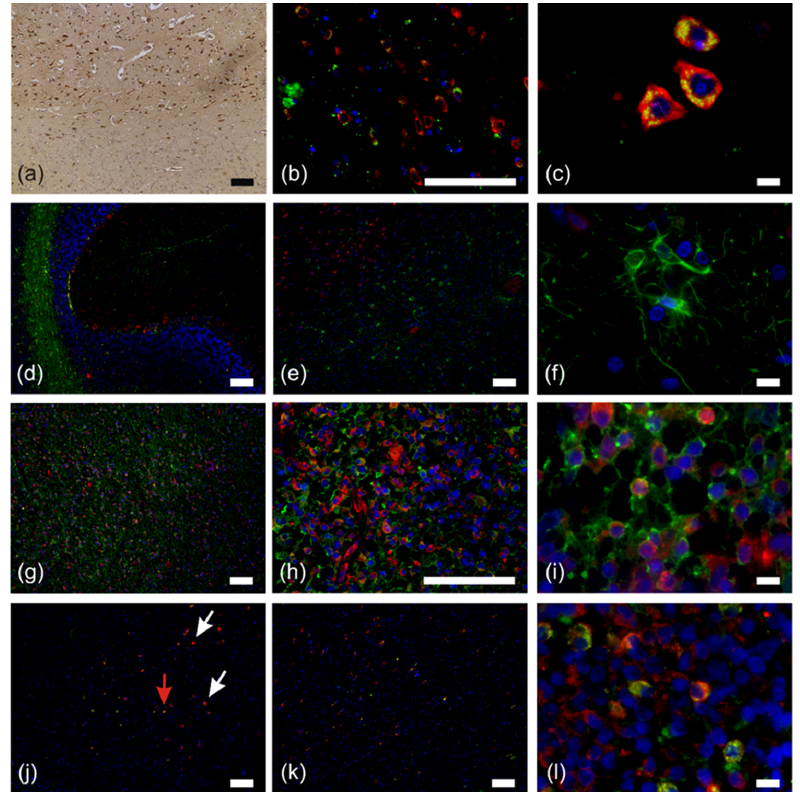
Figure 2. Fluorescence double staining of normal brain and astrocytic tumor specimens. ( a ) RPS27-DAB staining of normal brain tissue. Positive cells were concentrated in the grey matter of the frontal cerebrum. ( b ) and ( c ) neurons (NeuN = green, RPS27 = red) in the frontal cerebrum. ( d ) Overview of the cerebellum double stained for RPS27 (red) and astrocytes (glial fibrillary acidic protein, GFAP = green). ( e ) Neurons and astrocytes in the frontal cerebrum (RPS27 = red, GFAP = green) and ( f ) astrocytes in 100× magnification (RPS27 = red, GFAP = green). ( g – i ) Glioblastoma (GBM) cells in the cerebellum. RPS27 = red, GFAP = green. ( j ) Diffuse IDH1 R132H mutant GBM. (RPS27 = red, IDH1 R132H = green). Red arrow = RPS27/IDH R132H double positive tumor cell, white arrows = RPS27-positive but IDH1 R132H-negative cells. ( k ) and ( l ) GBM double staining for RPS27 (red) and macrophages (CD68 = green). DAPI = blue, scale bars in ( c ), ( f ), ( i ), and ( l ) = 10 µm, otherwise scale bars = 100 µm.